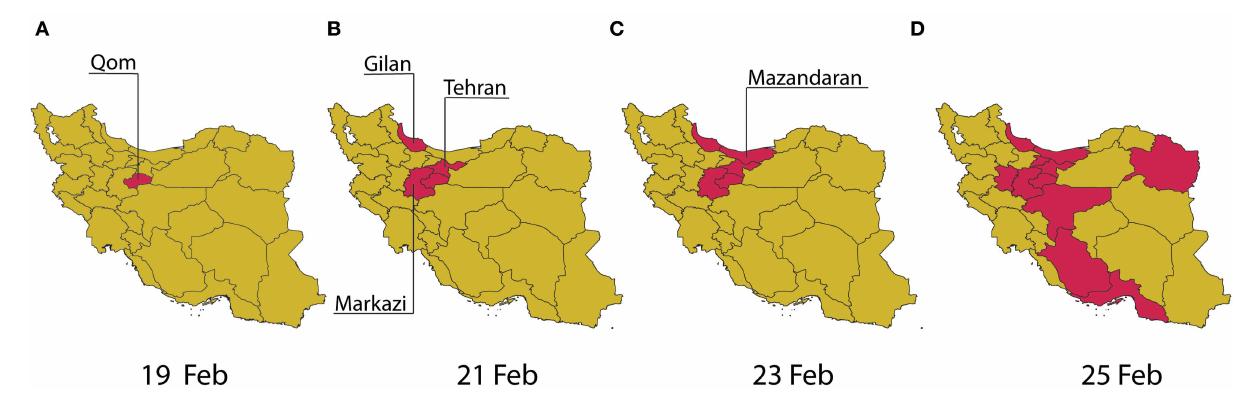
FIGURE 1 | Spatial illustration of the spread of COVID-19 in Iran by province in the first week of the official outbreak announcement from 19 February to 25 February 2020 (A–D)